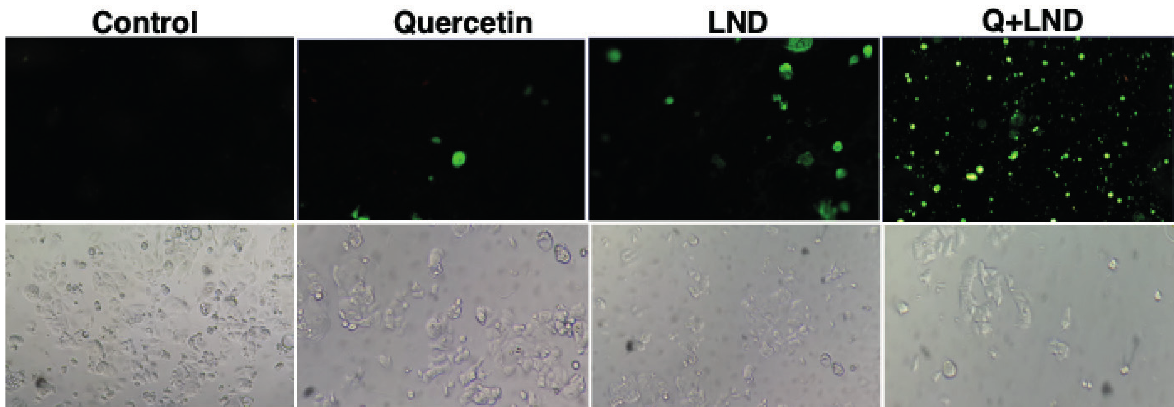
Figure 4. Fluorescence microscopy analysis of Annexin V-FITC staining. MCF-7 breast cancer cells were left untreated (control) and treated with 80 μM of quercetin and 5 μM of LND alone, and 80/5 μM Q+LND combination for 24 hr, and the fl uorescence images were obtained by Annexin V staining protocol according to the instructions (BD Biosciences, Germany) through fl uorescence microscope (Olympus, Germany).